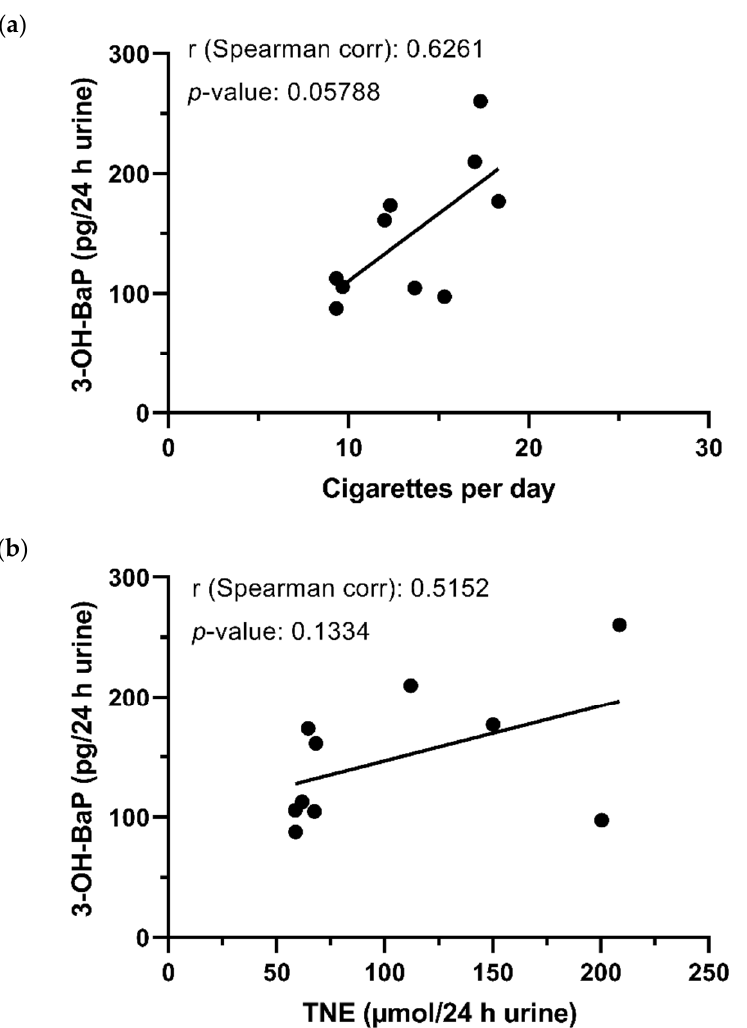
Figure 5. Spearman’s correlation between urinary 3-OH-BaP concentrations and ( a ) number of cigarettes smoked per day (CPD) and ( b ) urinary total nicotine equivalents (TNE) of CC users on Day 3 (N = 10).